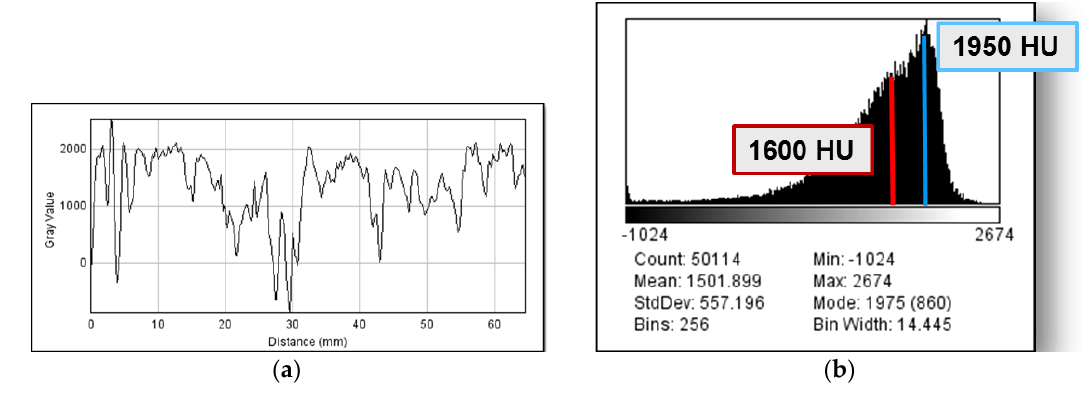
Figure 4. X-ray absorption coefficients (HU) distribution ( a ) and histogram ( b ) at the middle height of Figure 3b (blue line).